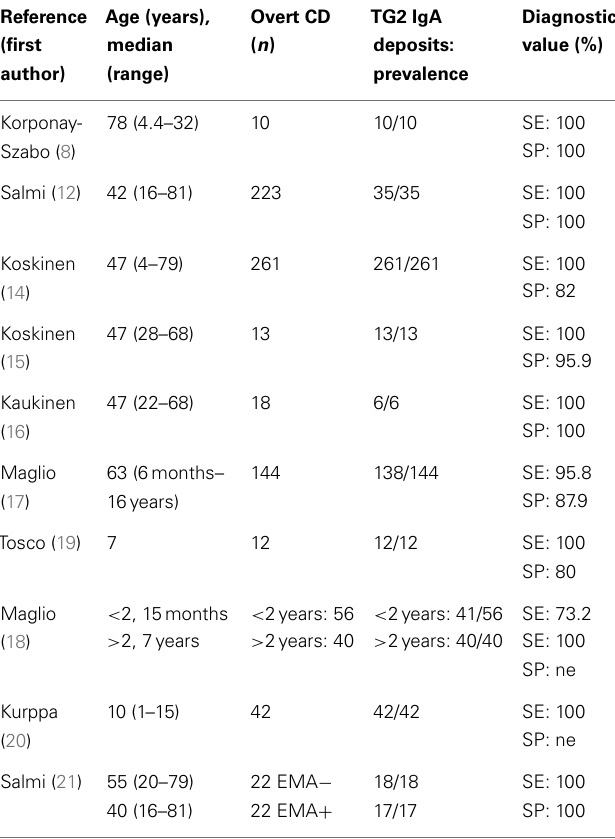
Table 2 | Summary of the included studies evaluating the presence of intestinalTG2 deposits in overt celiac disease (CD)